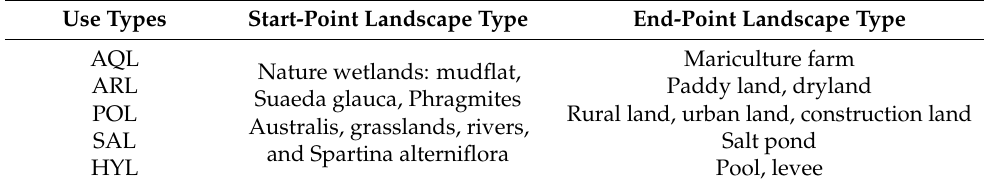
Table 2. The identification of use types of reclamation according to their start-and end-point land- scape